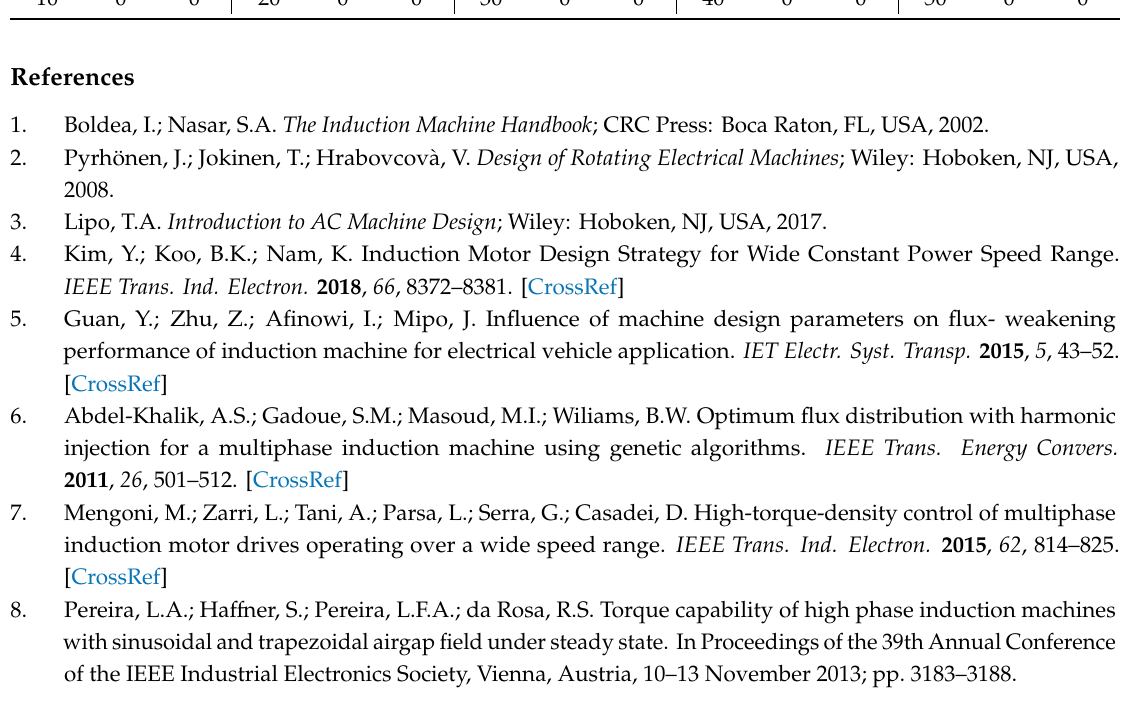
Table A 4. Harmonic winding factors of the five ‐ phase winding.